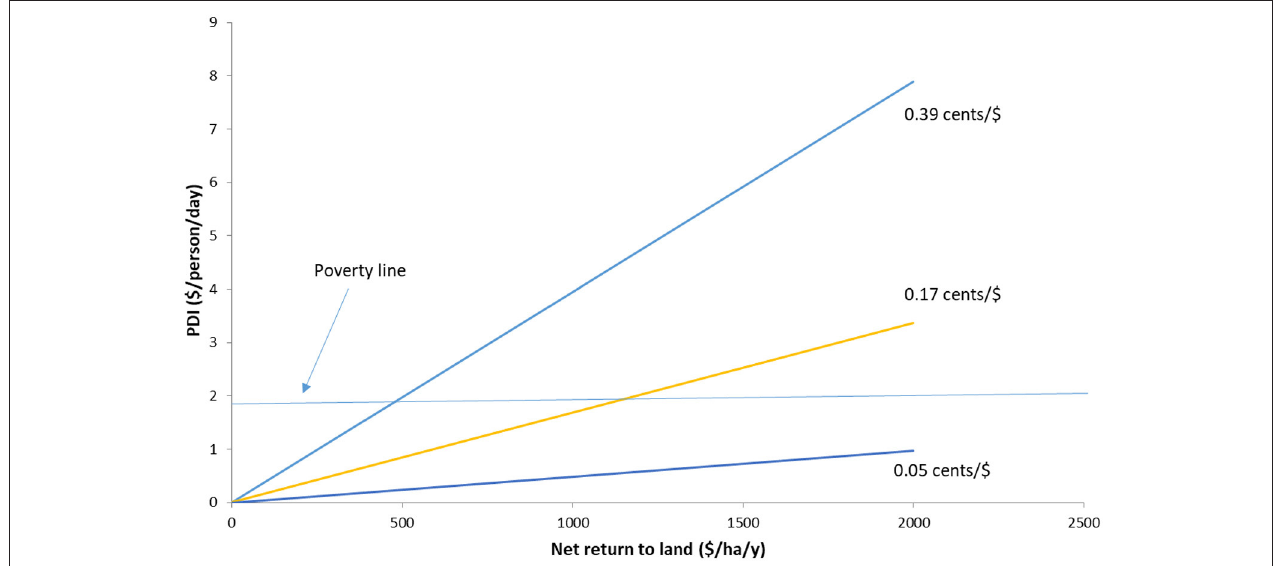
FIGURE 1 | Relation between personal daily income (PDI) and annual returns to land for three exemplar households that vary in size and farm size. IBI is the gradient of the line for each household and the International Poverty Line of $1.90 per person per day is also shown.